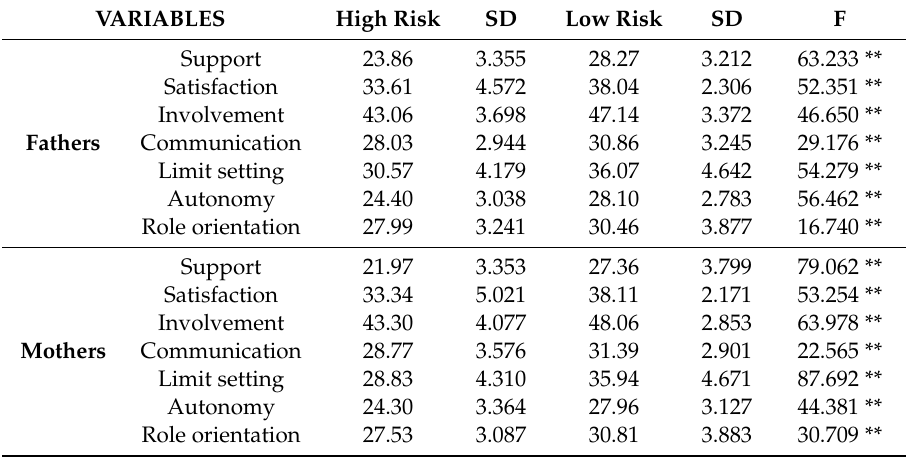
Table 1. ANOVA between the two groups for parenting